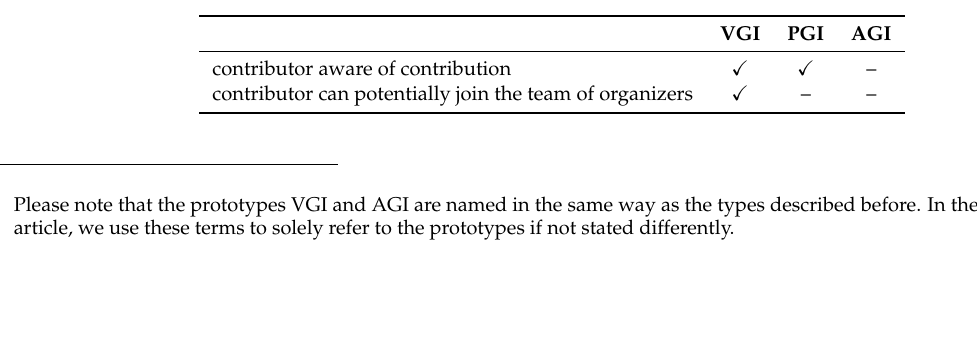
Table 1. Simplified systematic overview of the